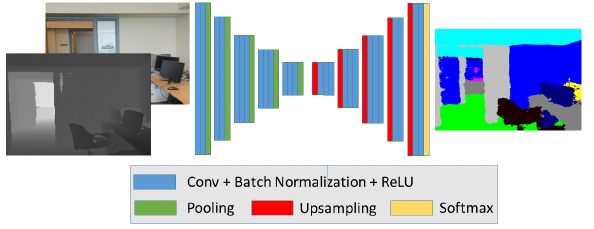
Figure 1. SegNet based encoder-decoder architecture for semantic labeling using RGB and depth